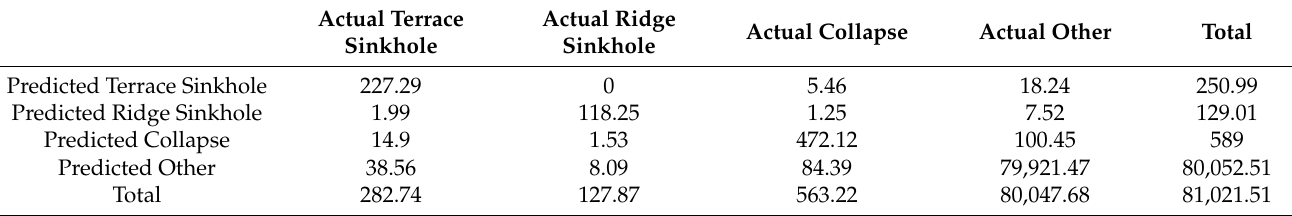
Table 3. Confusion matrix between classification result and ground truth (area: m 2